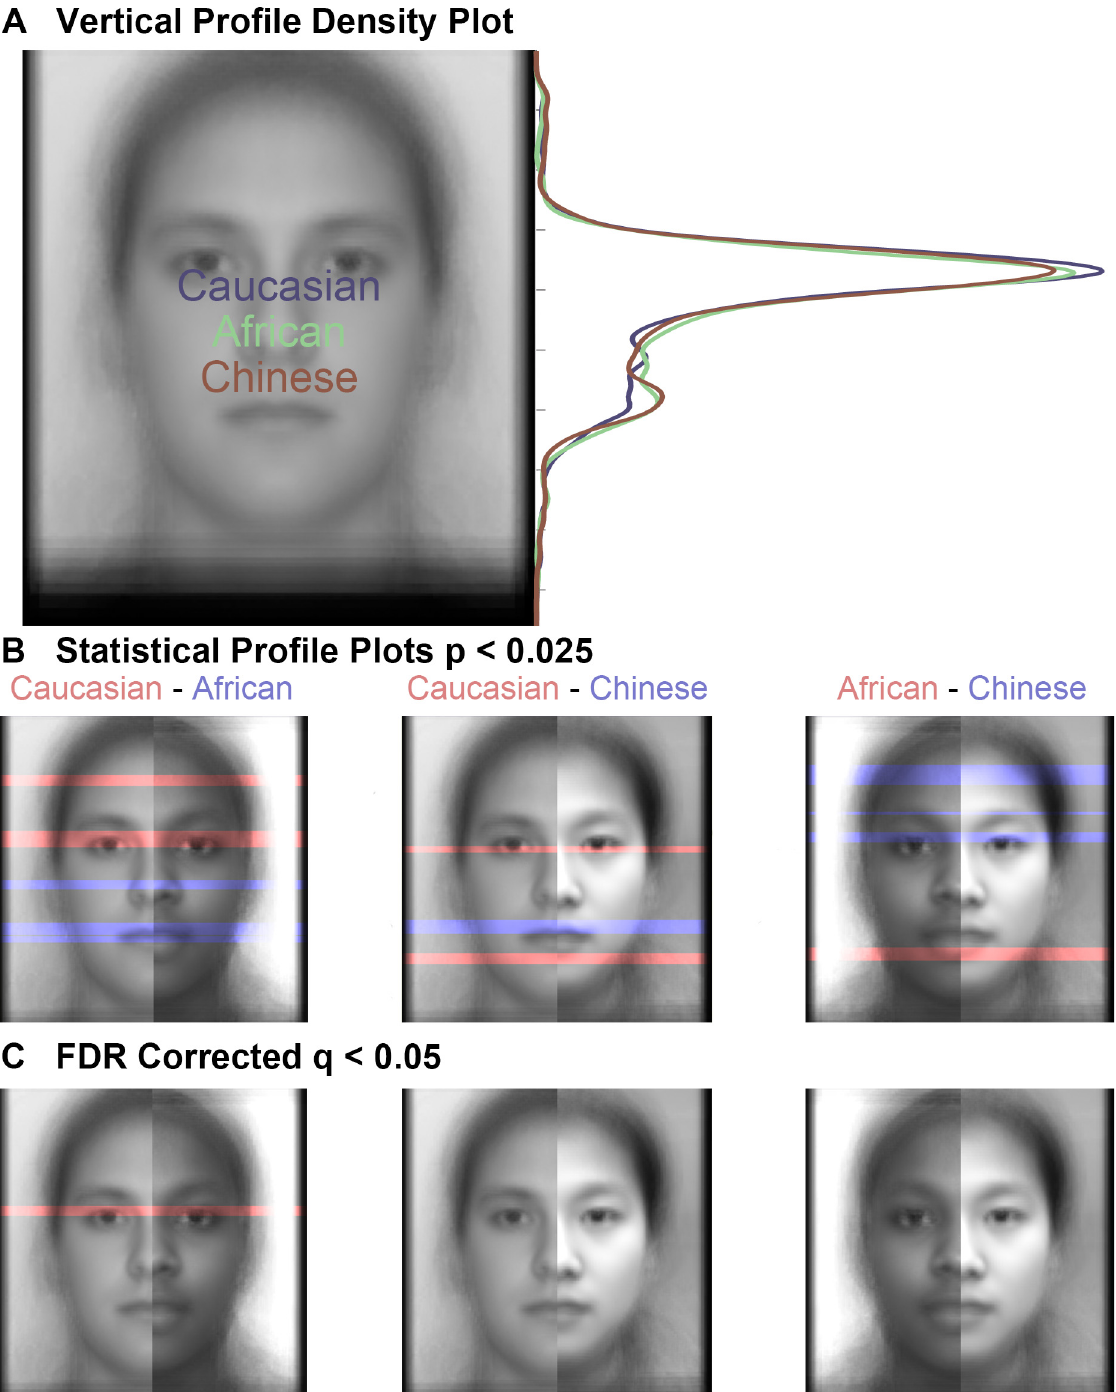
Fig 6. Vertical profile density plots and profile contrast plots. (a) Vertical profile densities for Caucasian, African, and Chinese faces suggesting numerically greater fixations density over the eyes and numerically lesser fixation density over the mouth for own- than other-race faces. (b) Statistical profile plots thresholded at p < 0.025, uncorrected, suggesting significantly greater fixation density over the eyes and numerically lesser fixation density over the mouth for own- than other-race faces. (c) The same statistical profile plots from (b) FDR corrected at q < 0.05 reveal that a relatively greater fixation density over the eyes for Caucasian than African faces survives the